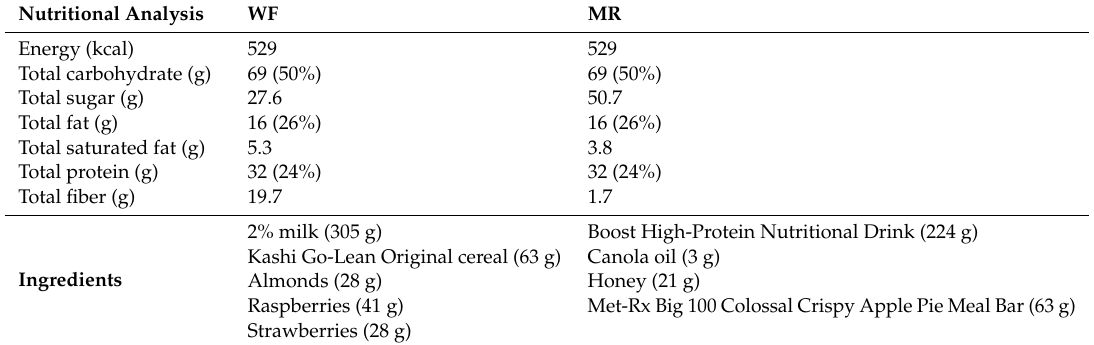
Table 1. Nutritional analysis and ingredients of the two test